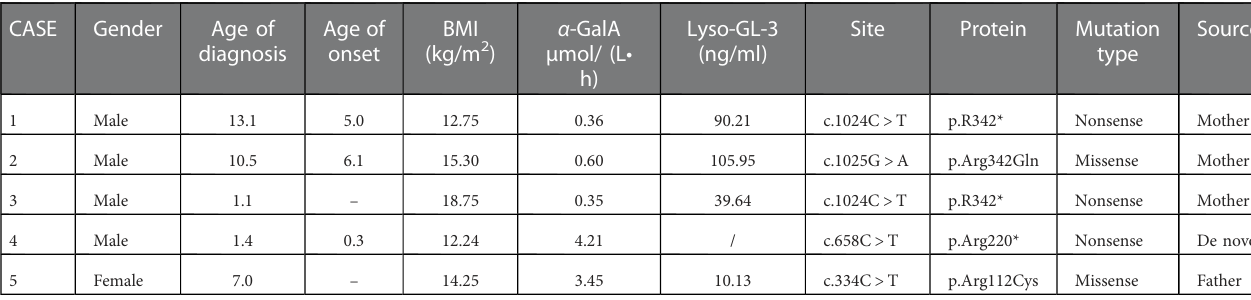
TABLE 1 Clinical data of children with